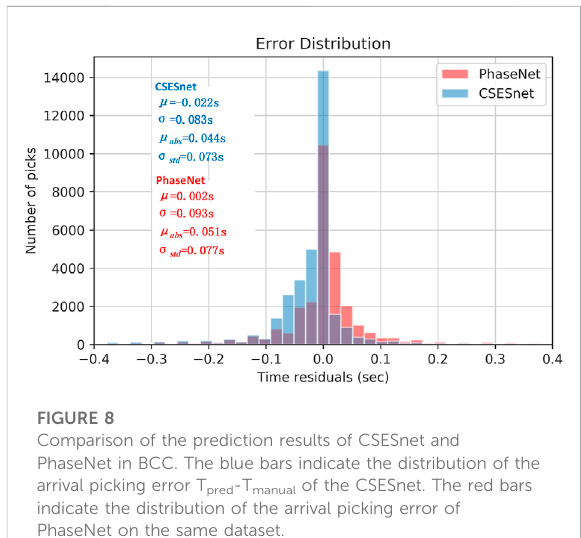
FIGURE 8 Comparison of the prediction results of CSESnet and PhaseNet in BCC. The blue bars indicate the distribution of the arrival picking error T pred -T manual of the CSESnet. The red bars indicate the distribution of the arrival picking error of PhaseNet on the same dataset.